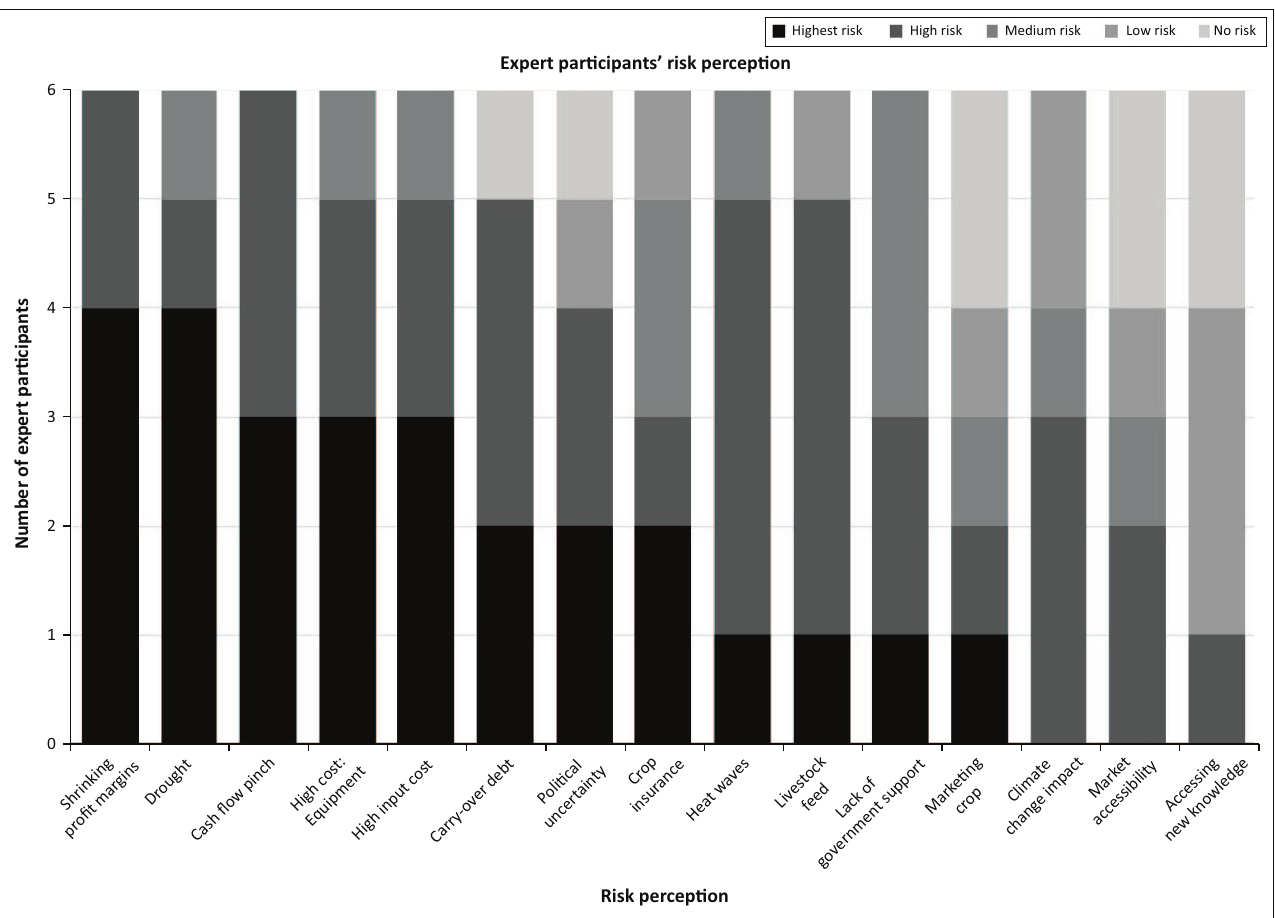
FIGURE 6: Risk Perception Index of expert